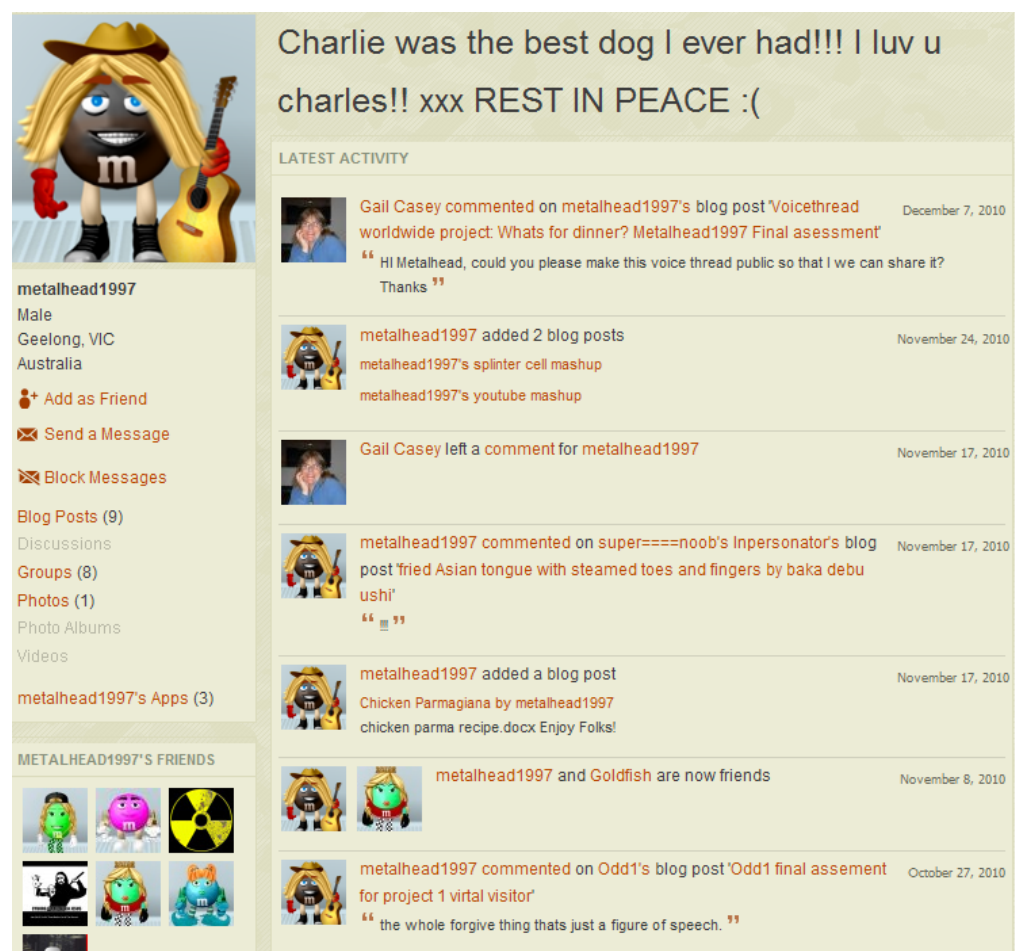
Figure 5. Screen clip of a student’s My Page where he organized his theme, profile, and avatar, and published work and